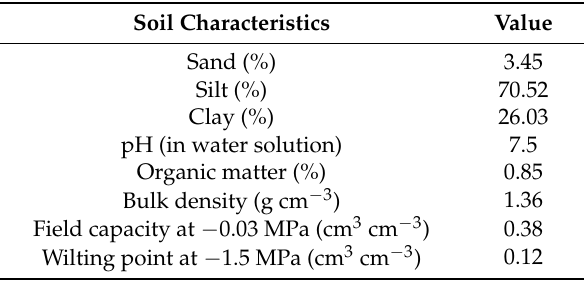
Table 1. Characteristics of experimental soil in the upper layer (0–50 cm).